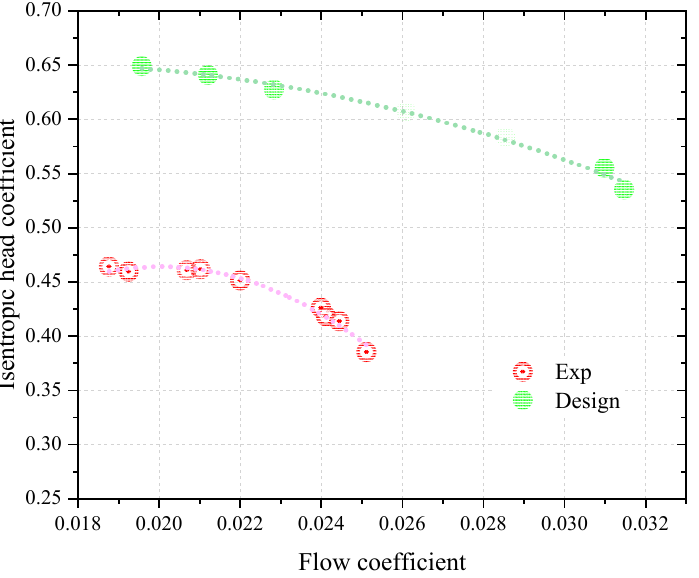
Figure 15. Comparison of dimensionless isentropic head coefficient performance curve.